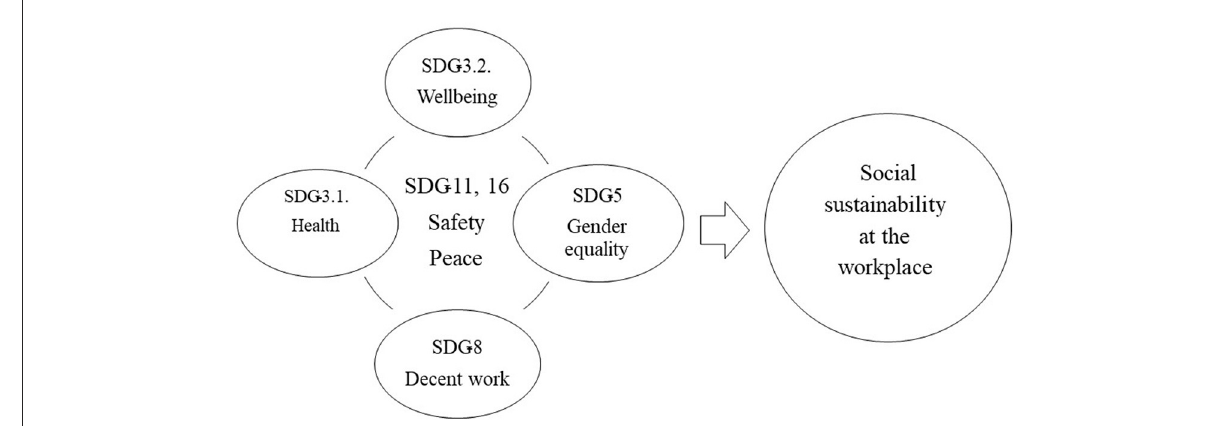
FIGURE1 Hypothetical model of key sustainable development goals for social sustainability in the workplace at the start of the new